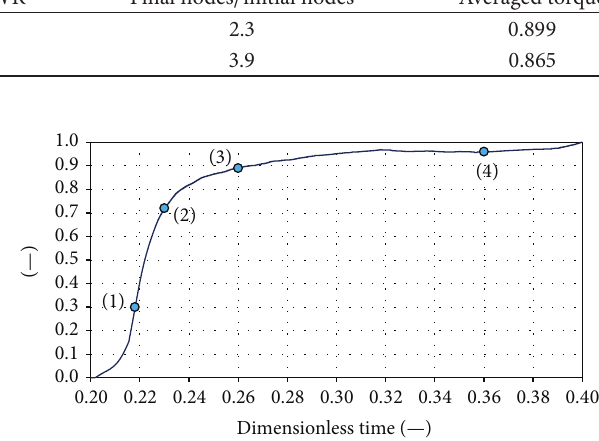
Figure 18: Second impact data related to run 3D-2: cumulative torque curve